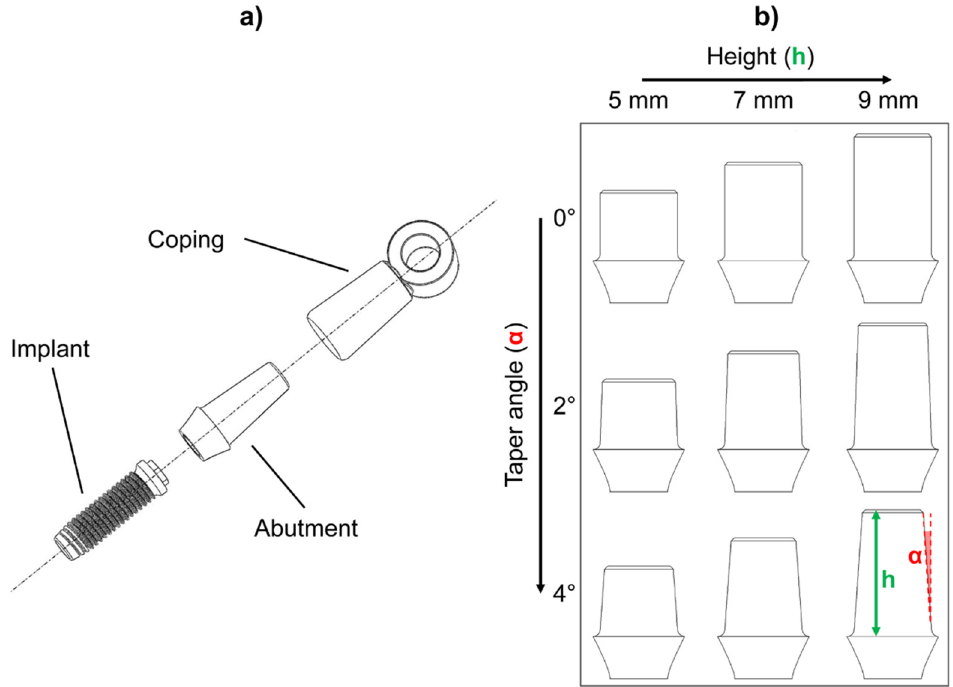
Figure 2. ( a ) Exploded view of the implant–abutment–coping assembly (9 mm–4° combination is shown as an example): the ring for the housing of the removal tool loop is positioned at the coping top. ( b ) The nine abutment geometries realized according to each height/taper angle combination. Height (h) variation is shown along rows while the taper angle ( α ) variation is shown along the columns.